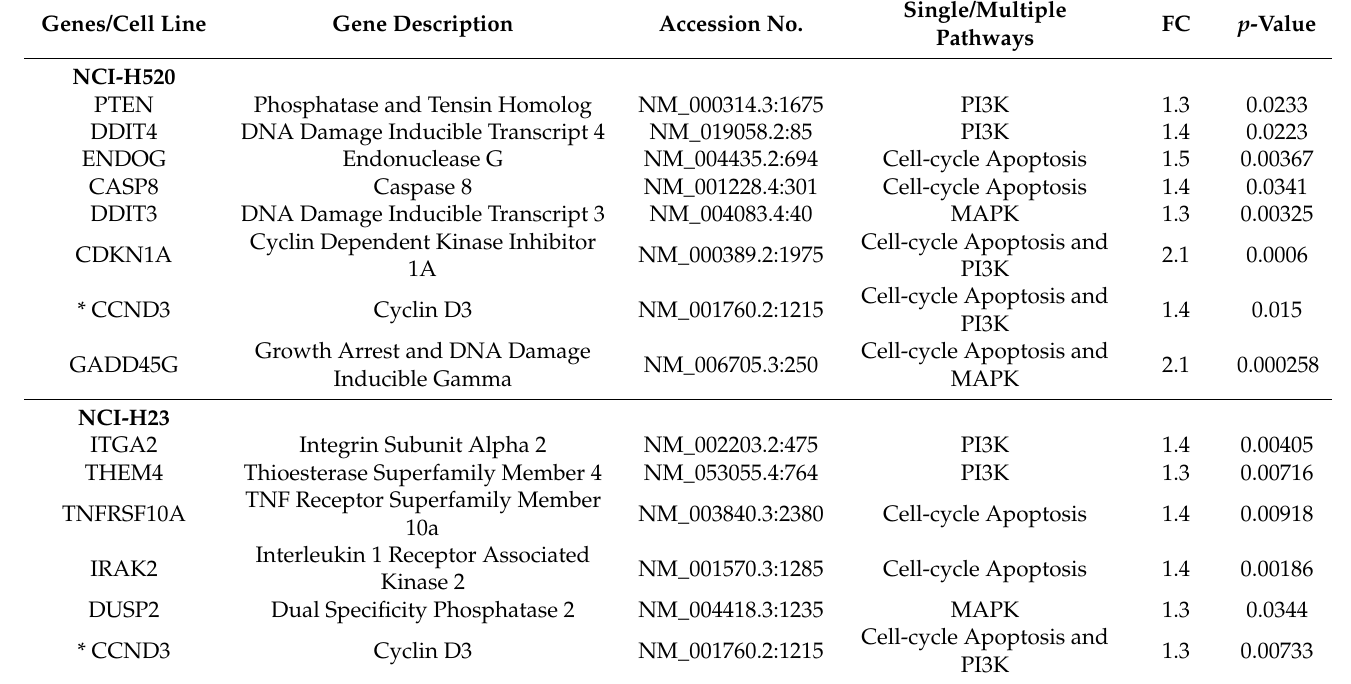
Table 2. Upregulated DEGs in NCI-H520 and NCI-H23 cells in response to MS13 treatment.